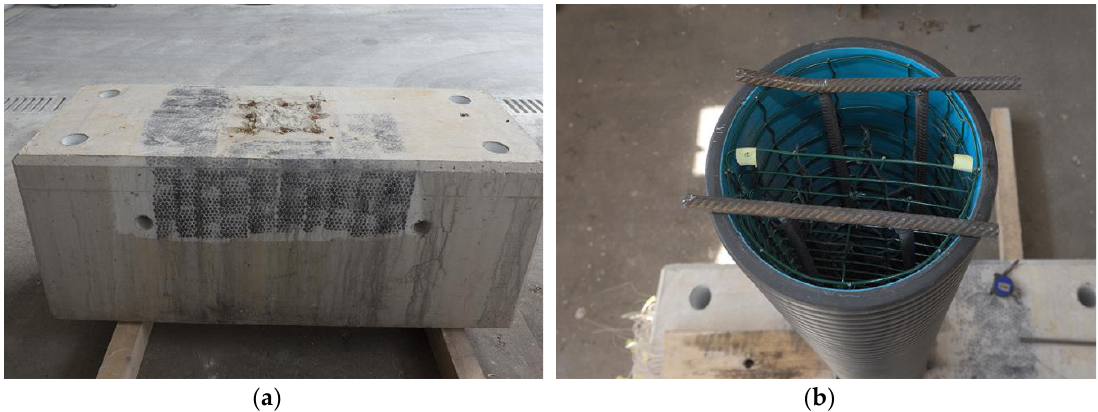
Figure 5. ( a ) A concrete block; ( b ) Tube ready for pouring concrete.